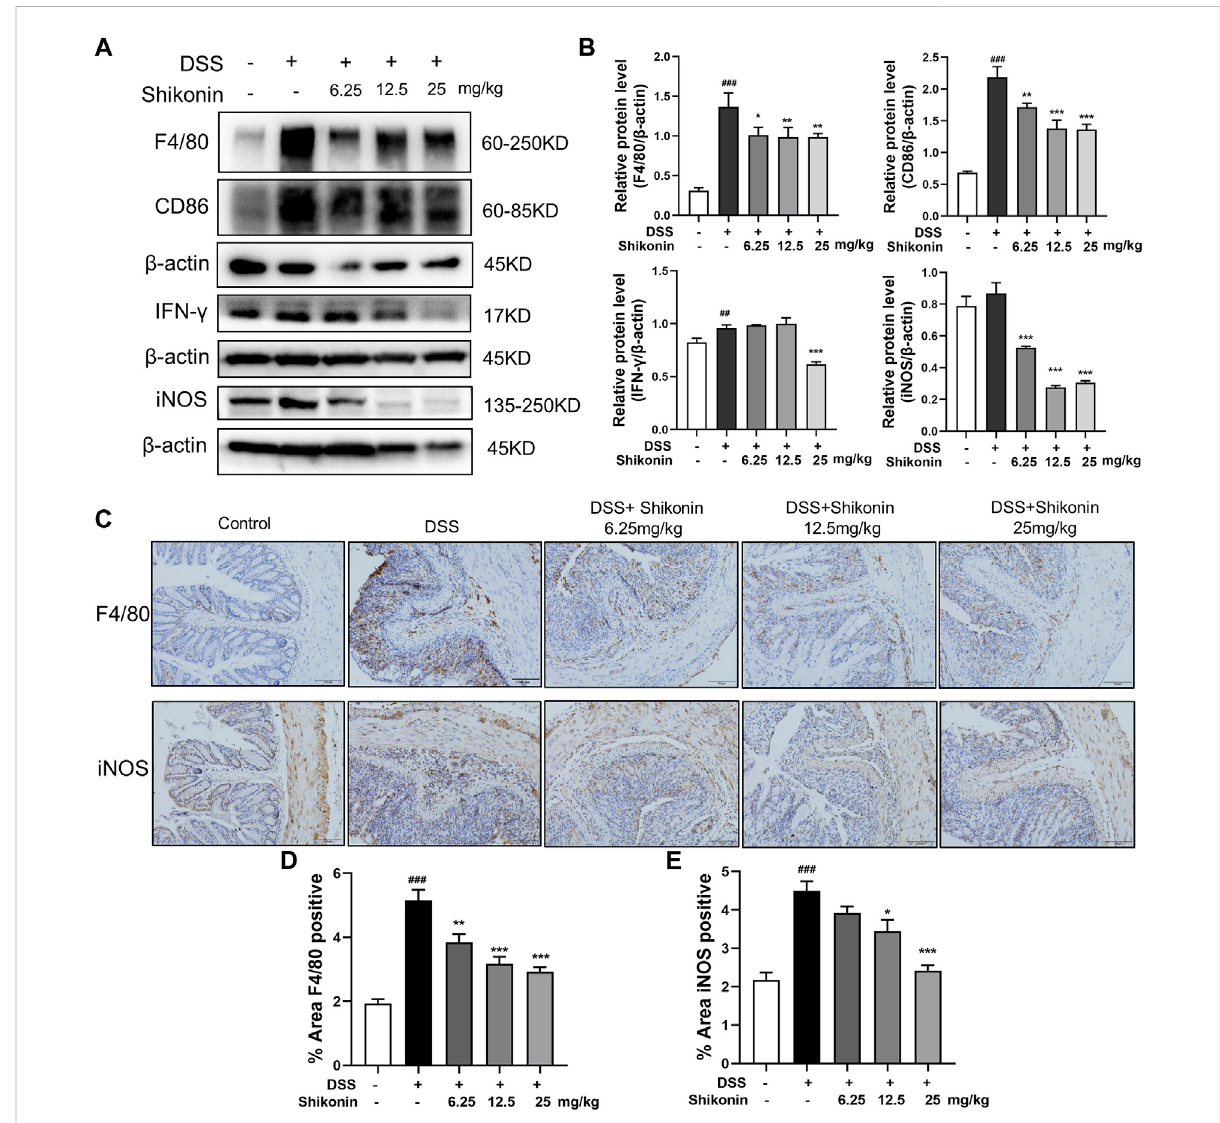
FIGURE 2 Shikonin inhibited macrophage polarization in DSS-mice. The protein level (A) and statistics (B) of F4/80, CD86, IFN- γ and iNOS measured by Western blots. The F4/80and iNOS (C) level of colitis were detected by immunohistochemistry assay with statistics (D – E) . Data are shown as the mean ± SD, n = 5 – 8. ## p < 0.01, ### p < 0.001, compared to the control group. * p < 0.05, ** p < 0.01, *** p < 0.001, compared to the DSS